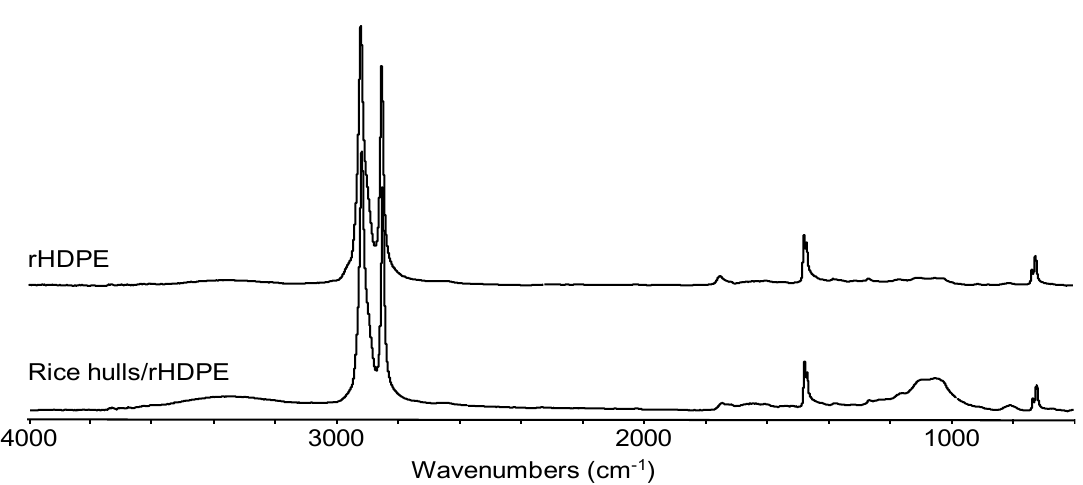
Figure 5. FTIR of recycled HDPE (top) and rice hulls ( < 0.5 mm) / rHDPE composite (bottom).